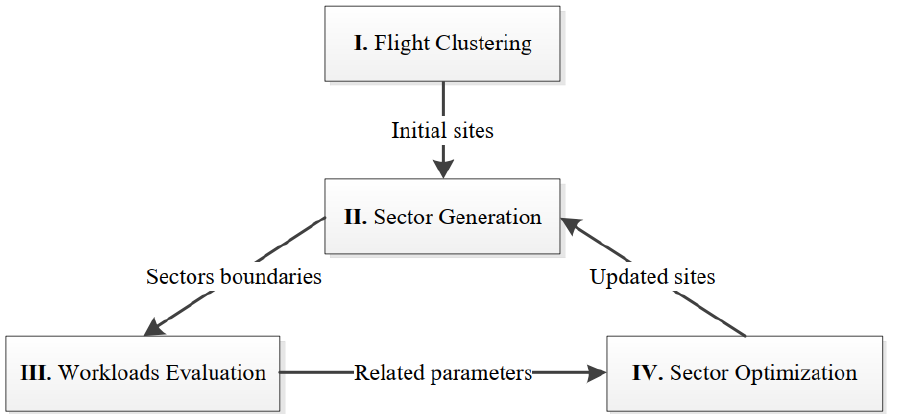
Figure 1. Proposed framework for 3D airspace sectorization.